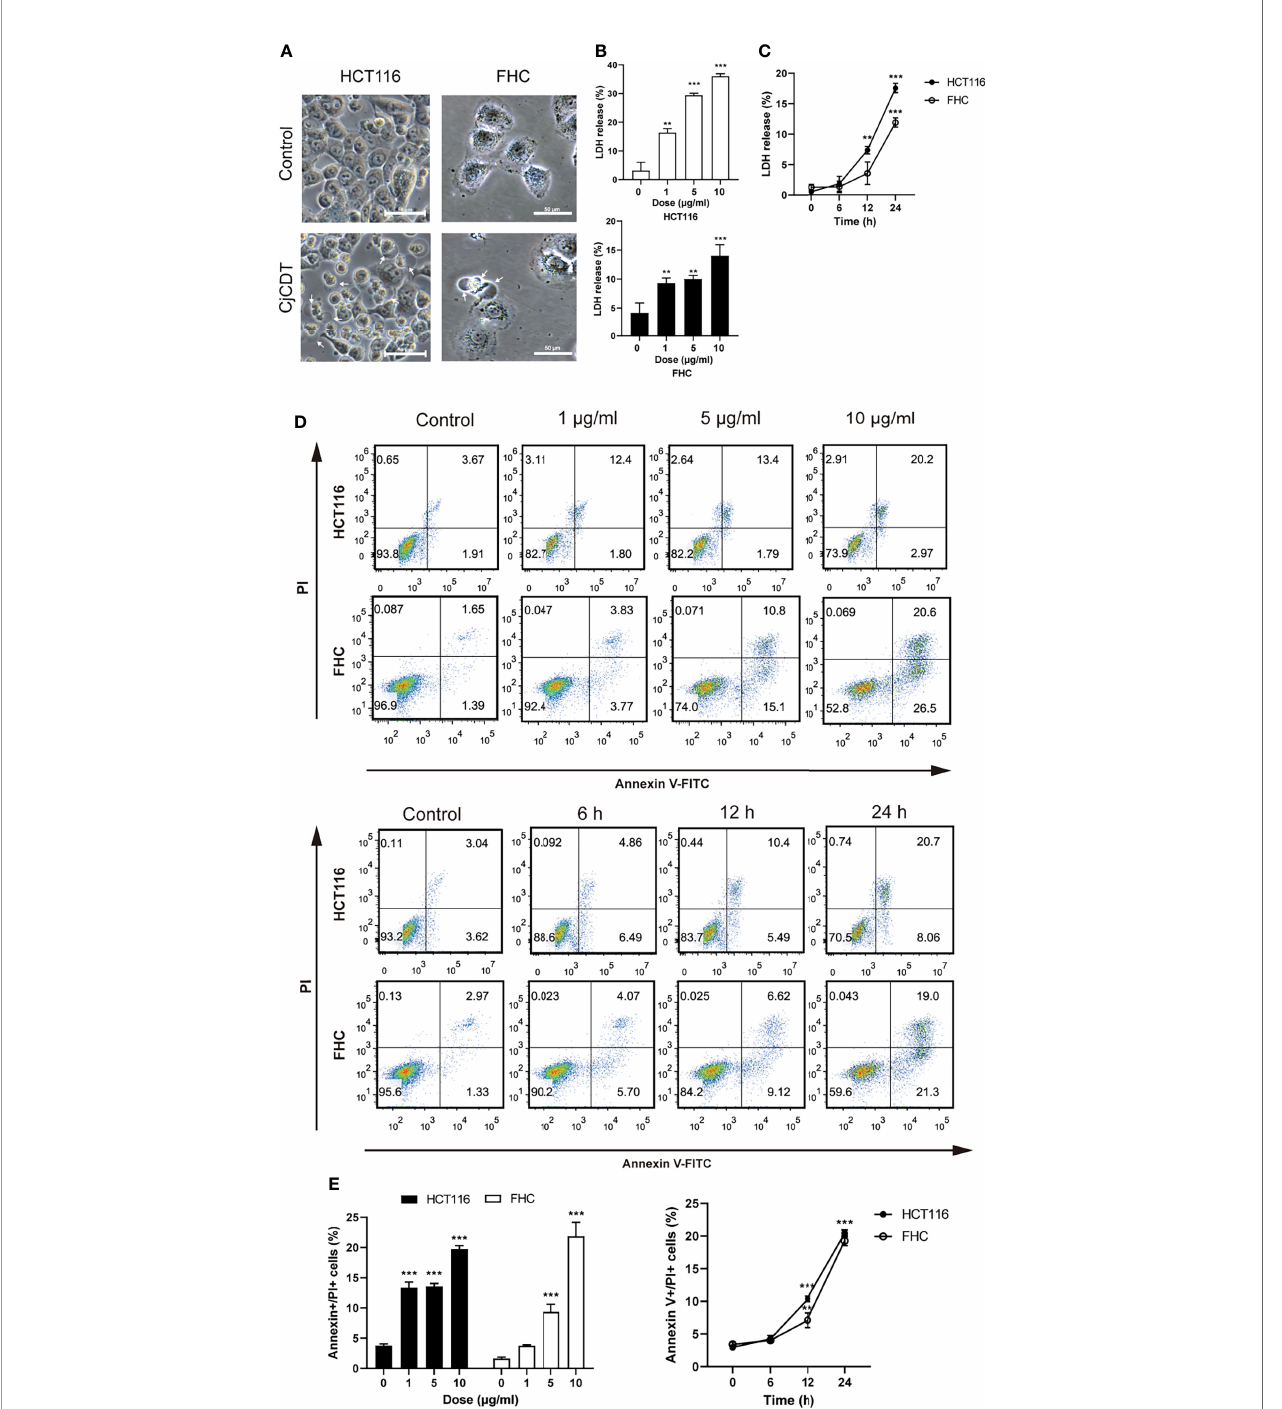
FIGURE 2 | CjCDT changes cellular morphology and induces cell death in HCT116 and FHC cells. (A) After cells were treated with 10 m g/ml CjCDT for 24 h, representation microscopic images were taken. White arrowheads indicate the pyroptotic cells characterized with large bubbles emerging from plasma membrane. Scale bar 50 m m. (B, C) LDH release was measured after different doses (0, 1, 5 and 10 m g/ml) of CjCDT treatment for 24 h or 10 m g/ml CDT treatment for different periods of time (0, 6, 12 and 24 h) in HCT116 and FHC cells (n=3). (D, E) Annexin V-FITC/PI assay was performed to determine the pyroptotic cells after CjCDT treatment with different doses (0, 1, 5 and 10 m g/ml) for 24 h or 10 m g/ml CjCDT stimulation for different periods of time (0.6, 12 and 24 h), and analyzed by fl ow cytometry (n= 3). **P < 0.01, ***P < 0.001 versus control using one-way